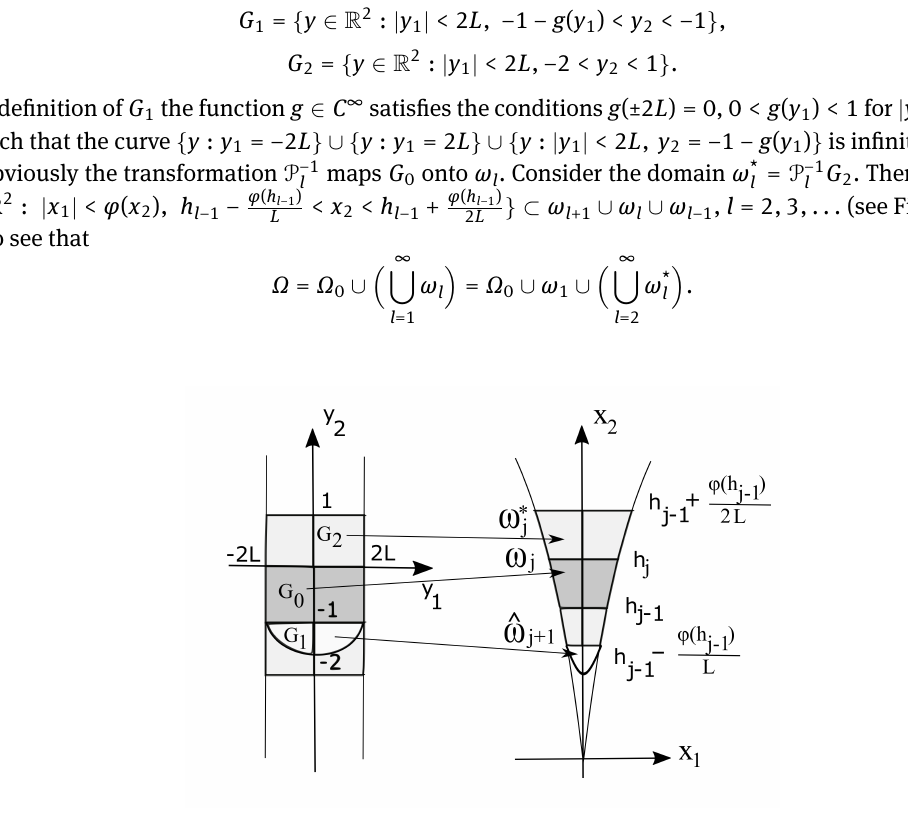
and ˆ ω in different coordinate j +1 j